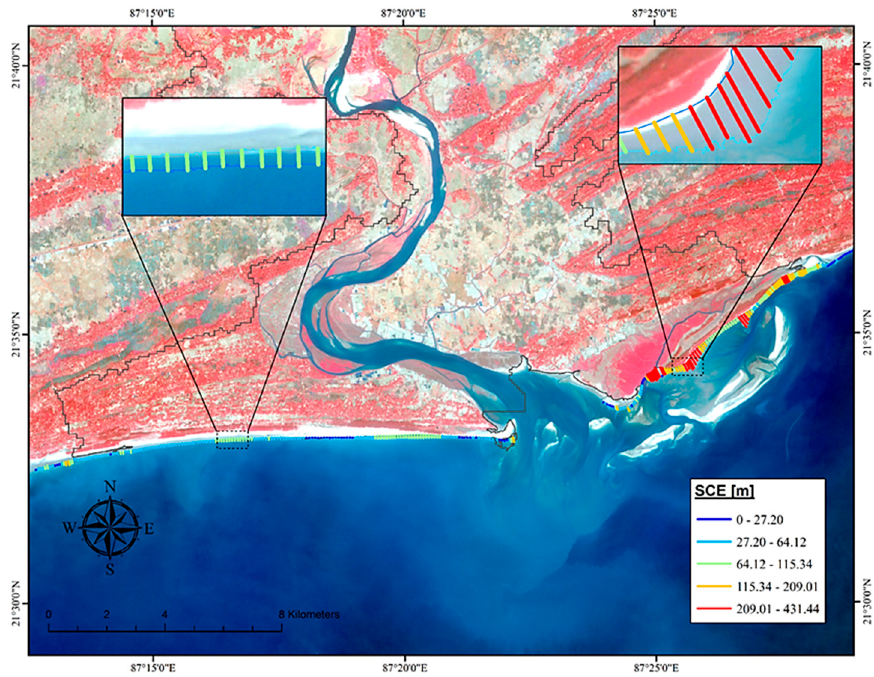
Figure 14. Transect-wise SCE of the Subarnarekha’s estuarine section (Digha Coast).